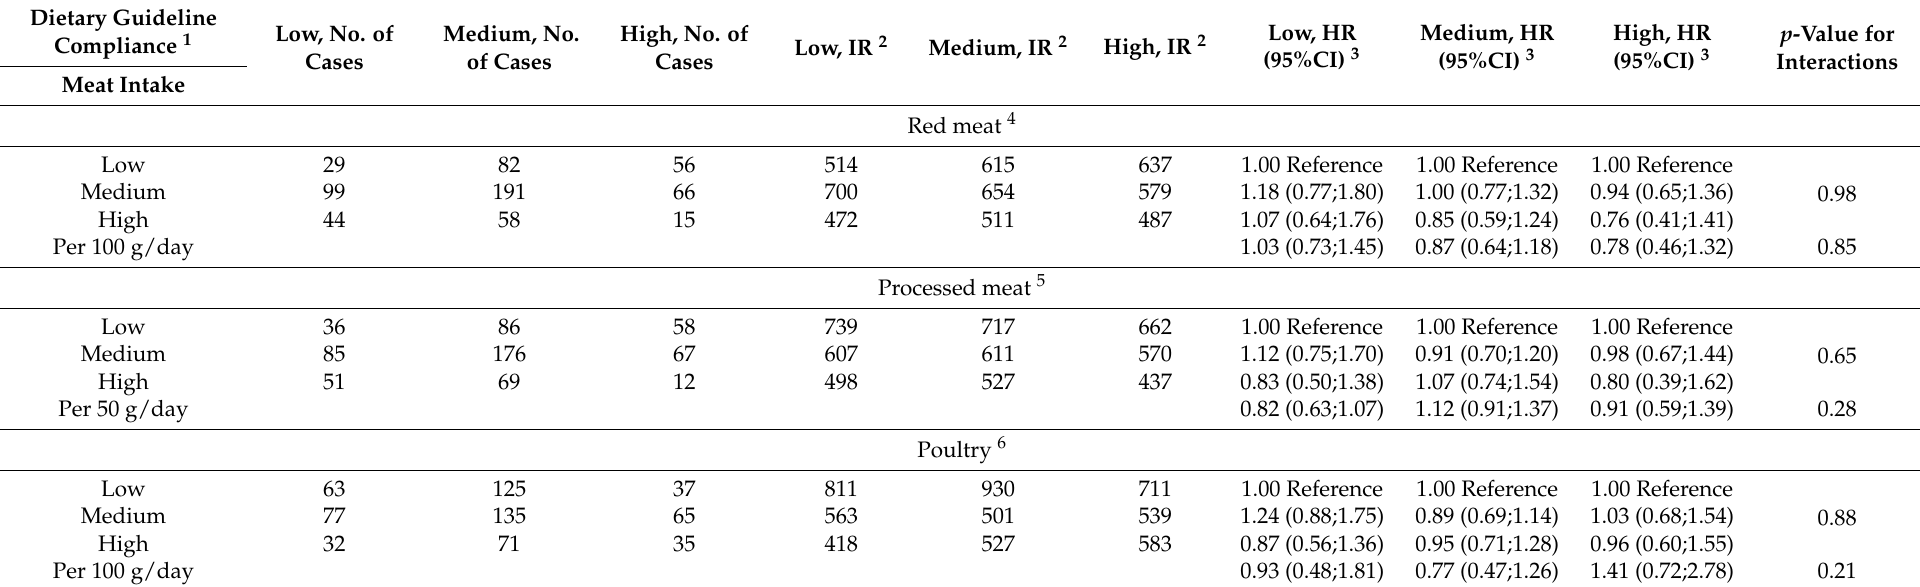
Table 8. Association between intake of different types of meat and risk of all-cause mortality. Stratified by dietary guideline compliance, n = 9848. Dietary